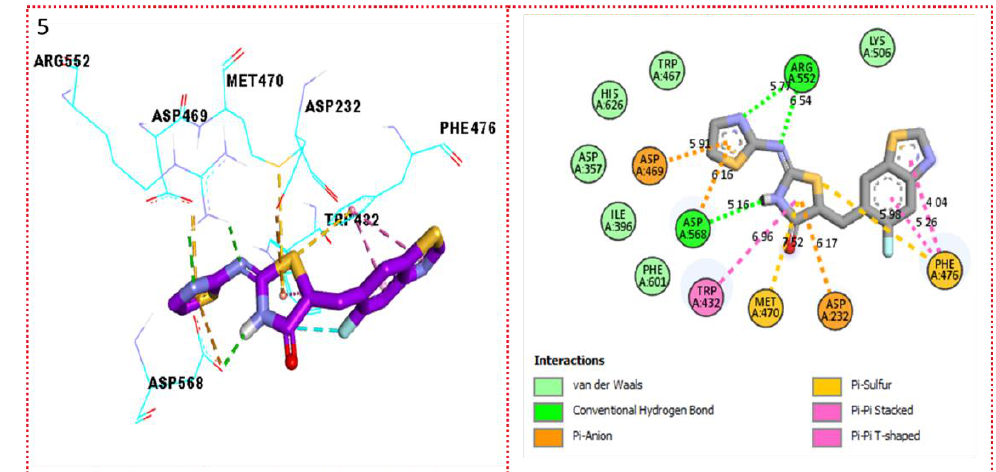
Figure 10. Protein – ligand interaction profile for active analogue against α‐ amylase represents the surface of the corresponding enzyme and indicates the PLI profile for compound 5 .